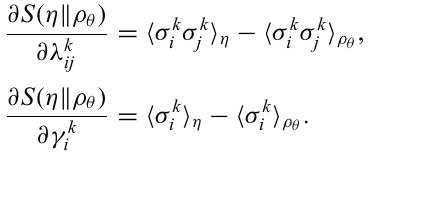
FIG. 6. The mean error of an ensemble of size n TPQ ∈ { 1, 5, 10, 100 } thermal pure states and different system sizes. For this, we compute the mean error on all possible one- and two- qubit Pauli observables. We see that for larger n , the required size of the ensemble, for a fixed mean error, becomes smaller, in accordance with the vanishing of the variance. For these simula- tions, we use the XXZ-Heisenberg model with J = 0.5, (cid:13) = 0.7, and closed boundary